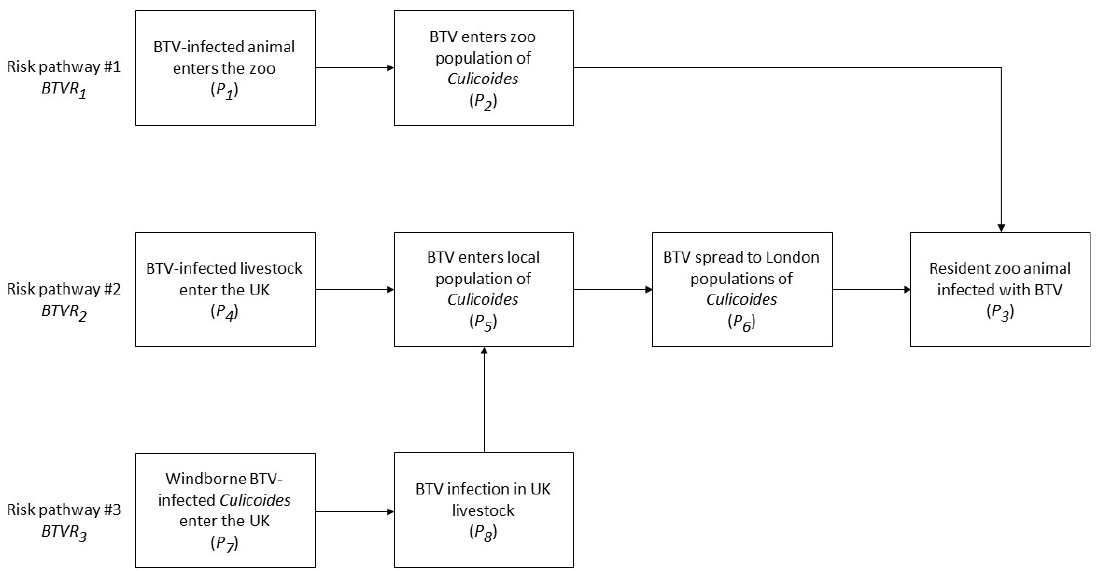
Figure 1. Risk pathways for the entry of BTV into ZSL London Zoo and exposure of susceptible resident animals.